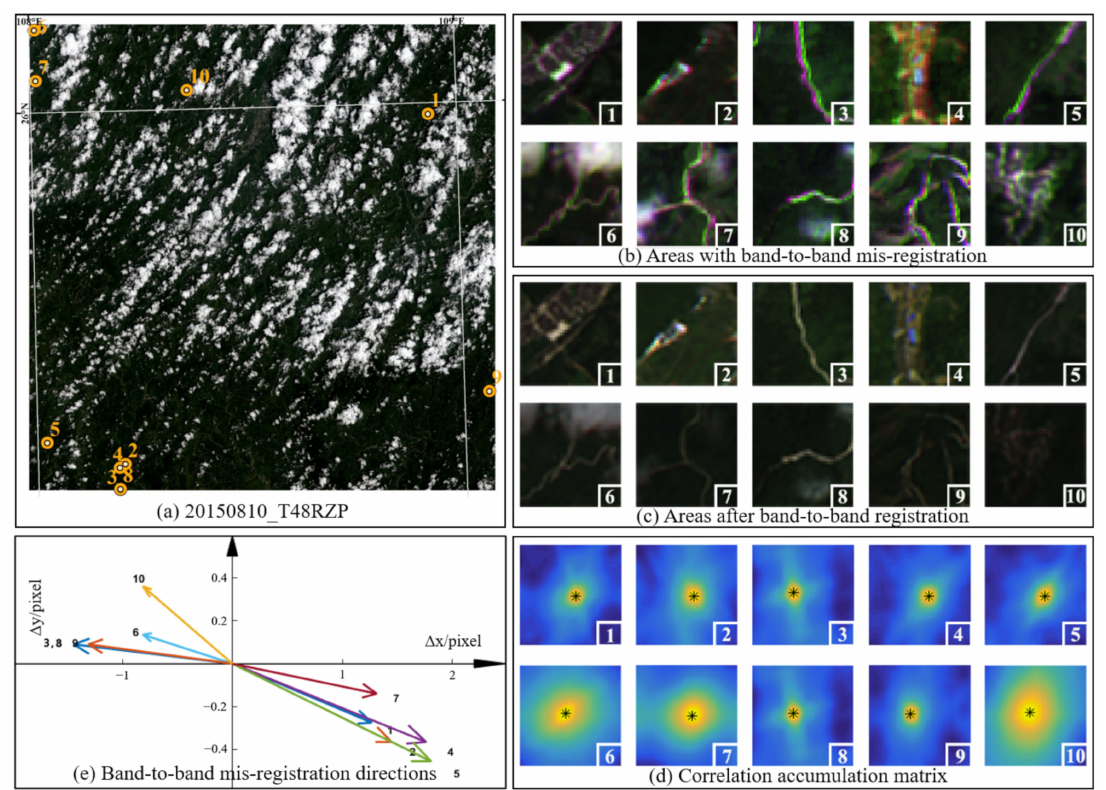
Figure 4. Inter-band offset directions and distances of different chips inside one scene. ( a ) Positions of 10 chips in scene 20150810_T48RZP, ( b ) original true-color images of these chips, ( c ) BBR results of these chips, and ( d , e ) different offset directions and distances of these chips. Note that image chips in ( b , c ) were zoomed in (40 × 40 pixels) to better present the spectral